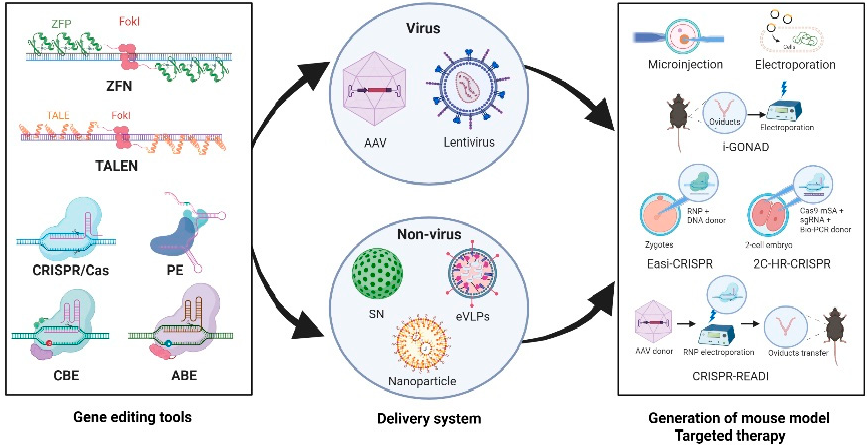
Figure 1. Delivery strategies for gene editing using programmable nucleases in mice. The genome editors, including ZFNs, TALENs, CRISPR/Cas, PE, CBE, and ABE, can be delivered to mice using viral (AAVs and lentiviruses) or nonviral particles (SN, nanoparticles, and eVLPs) via microinjections or electroporation. In addition, the programmable nucleases can be directly delivered to mice using the i-GONAD method without any ex vivo modifications. ZFNs, zinc finger nucleases; TALENs, tran- scription activator-like effector nucleases; CRISPR, clustered regularly interspaced short palindromic repeats; Cas, CRISPR-associated protein; PE, prime editor; CBE, cytosine base editor; ABE, adenine base editor; AAVs, adeno-associated viral systems, SN, sponge-like silica nanoconstruct; eVLPs, engineered DNA-free virus-like particles; i-GONAD, improved genome editing via oviductal nucleic acid delivery. * This illustration was created with BioRender.com (accessed on 1 February